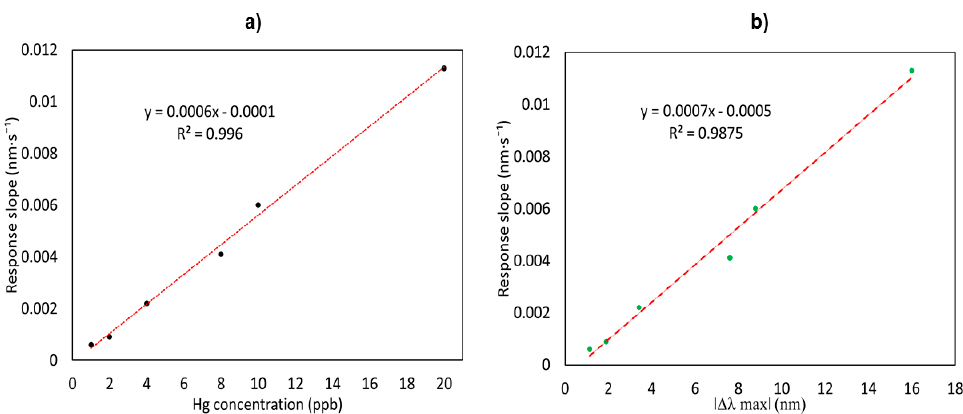
Figure 8. ( a ) Slopes of the linear fitting of the first 500 s vs. mercury concentration. ( b ) Correlation between the mercury measurement using the absolute wavelength shift of the LSPR, and the fast slope estimation.